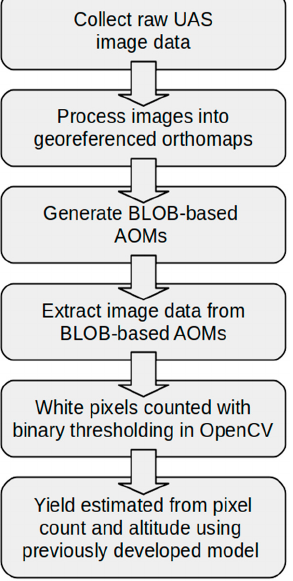
Figure 1. Flowchart of the unmanned aerial systems (UAS) image processing and yield estimation with a binary large object based area of measurement (BLOB-based AOM) data.